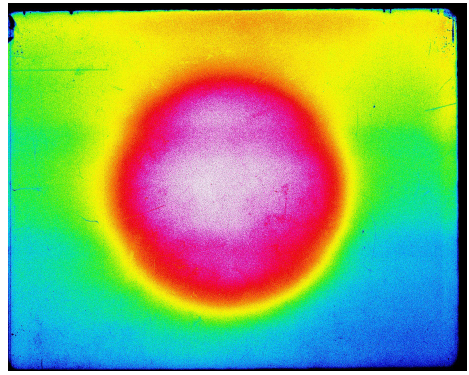
Figure 9. The neutrongram of neutron beam.